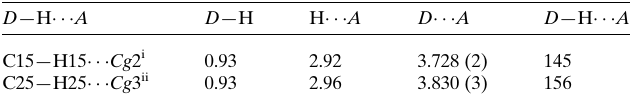
Table 1 Hydrogen-bond geometry (A˚ , (cid:2) ).